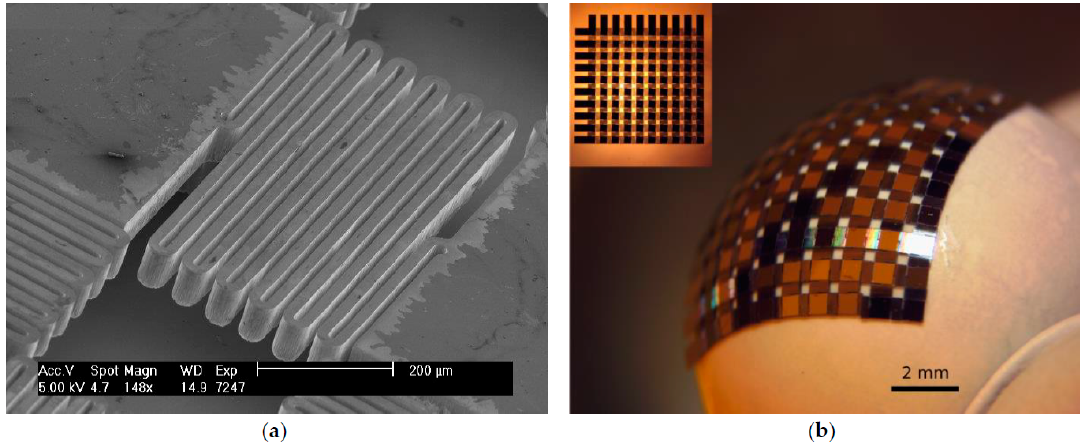
Figure 3. ( a ) SEM image of a silicon spring fabricated with the proposed process; ( b ) The stretchable monolithic device placed on a sphere with a radius of 8 mm, showcasing the possibility to bend it around multiple axes simultaneously. The smaller inset depicts the same silicon before